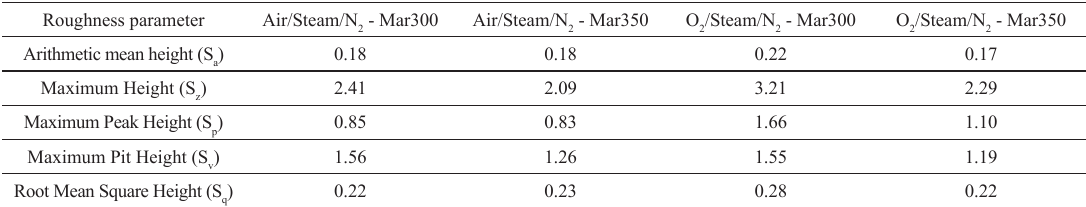
Table 3. Roughness parameters (in μm) for each investigated system according to ISO